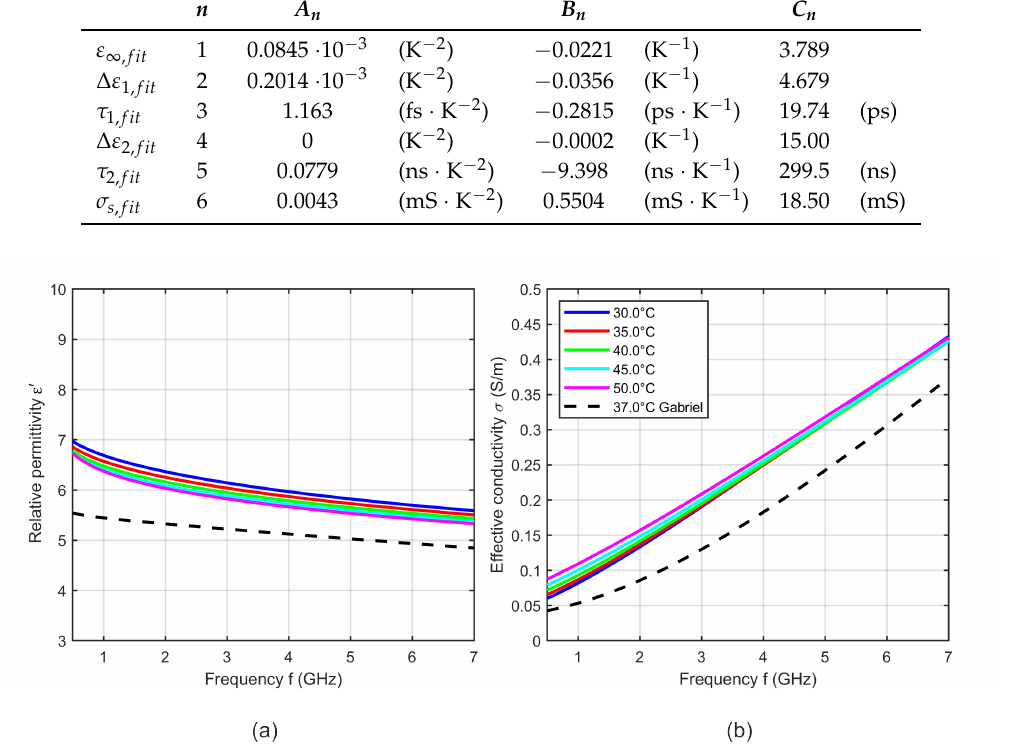
Figure 14. ( a ) Relative permittivity and ( b ) effective conductivity of porcine fat as a function of frequency at different temperatures. Black curves show the dielectric properties of fat reported by Gabriel [31] at 37 ◦ C.